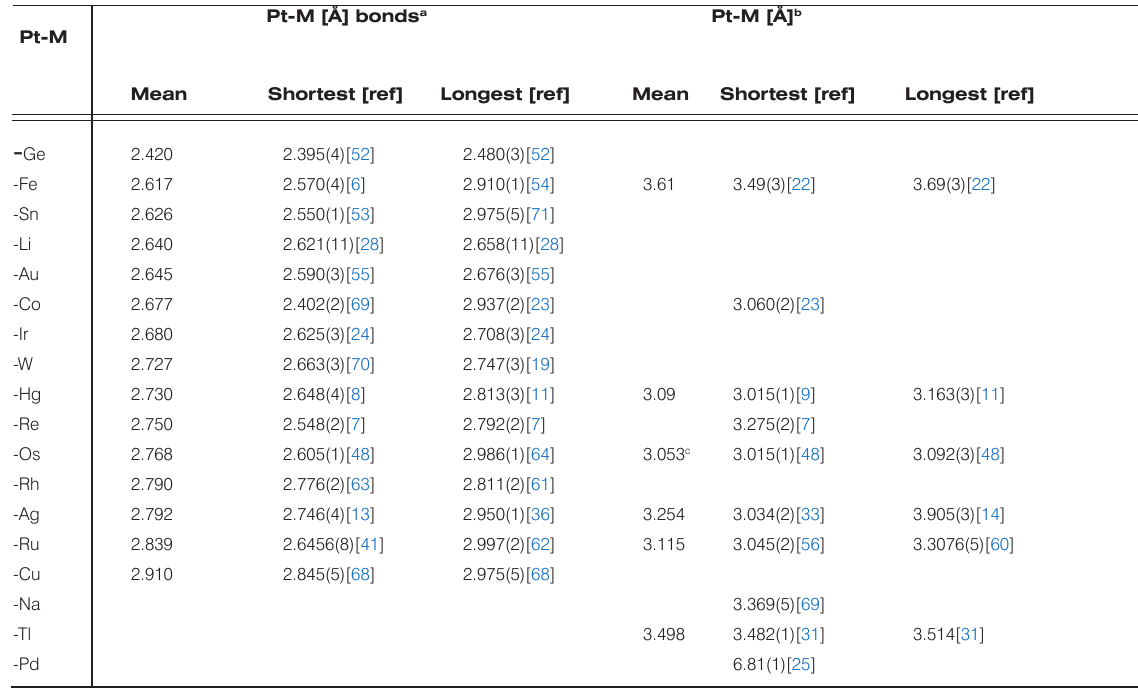
Figure 10. Structure of [(cod)PtOs Table 4. Summary of the mean Pt-M distances in heterohexanuclear platinum